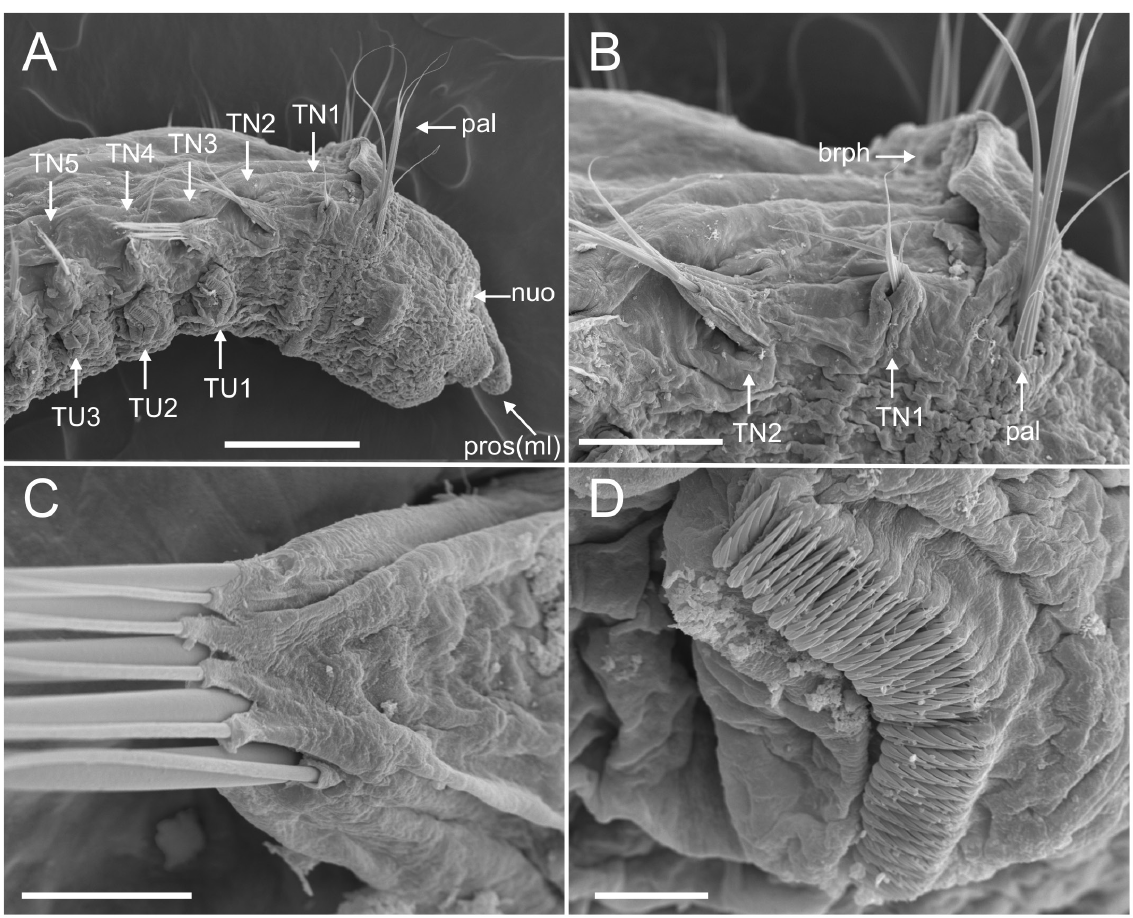
Fig. 2. Ampharete oculicirrata sp. nov., paratype MNCN 16.01/18482_spec. 1. A . Anterior end, lateral view. B . Paleae and first two thoracic chaetigers, lateral view. C . Thoracic notopodium and chaetae, anterior view. D . Uncini of second thoracic unciniger (thoracic chaetiger 4). Abbreviations: brph = branchiophore; nuo = nuchal organ; pal = paleae; pros(ml) = prostomium (median lobe); TN = thoracic notopodium; TU = thoracic unciniger. Scale bars: A = 200 µm; B = 100 µm; C = 20 µm; D = 15